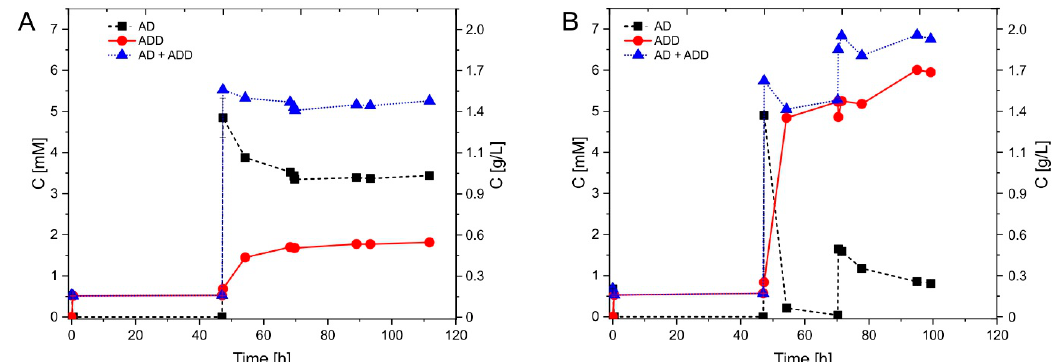
Figure 3. Progress curves of 1-dehydrogenation of androst-4-en-3-one (AD) to androst-1,4-dien-3-one (ADD) by ( A ) homogeneous AcmB and ( B ) immobilized MCF/GA/AcmB. The reaction was started with the addition of 0.5 mM AD and reinitiated at 47.5 h by the addition of 5 mM of AD. For AcmB: MCF/GA, additional 1.6 mM of AD was added at 70 h.